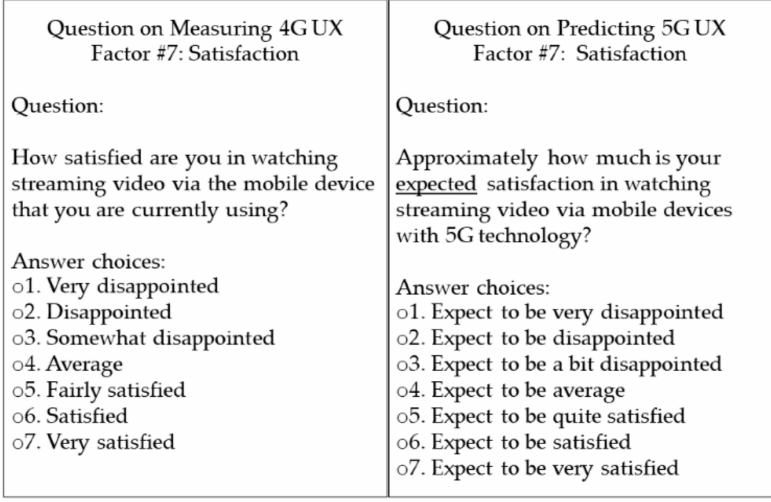
Figure 3. Sample questions on a questionnaire to measure 4G UX and 5G UX